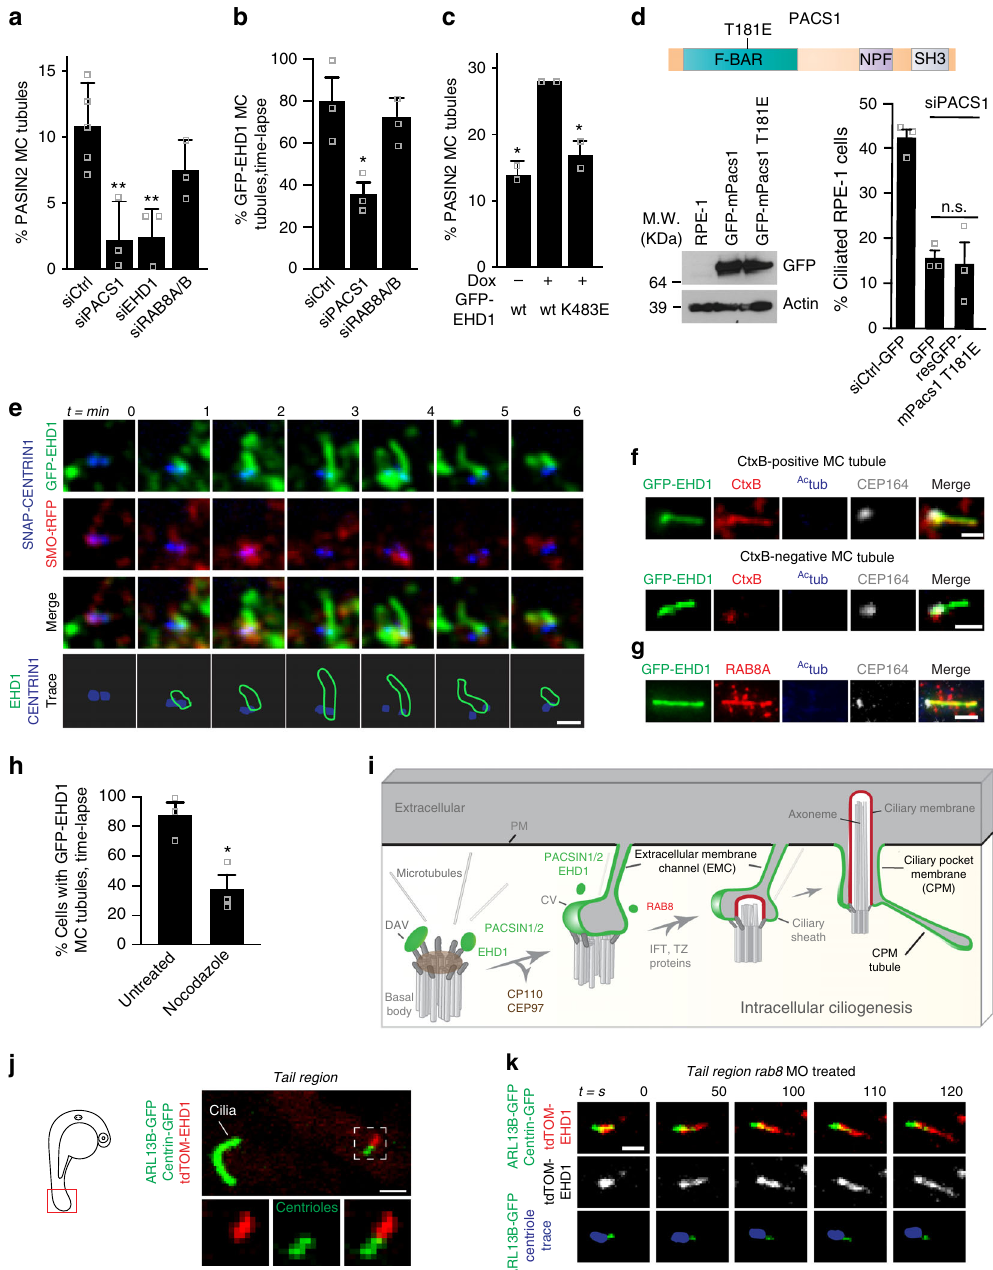
Fig. 8 MC-membrane tubules are PACSIN1-, EHD1- and MT-dependent and form in vivo. a Quanti fi cation of PACSIN2 positive MC-tubules in cells as in Fig. 6c following siRNAs treatments (siCtrl = 258 cells, n = 5; siPACS1 = 168, siEHD1 = 75, siRAB8A/B = 147 cells, n = 3). b Quanti fi cation of GFP-EHD1- positive MC-tubules from triple line treated with siRNAs, starved 3 h and imaged every 2 min for 30 min (siCtrl = 35, siPACS1 = 36, siRAB8A/B = 57 cells, n = 3). c Quanti fi cation of MC-tubules from cell lines starved for 3 h and stained with PACSIN2 and CEP164 antibodies (wt − dox = 262, wt + dox = 142, K483E + dox = 177 cells, n = 2). d Schematic of the T181E tubulation defective mutation in the F-BAR domain of mPacsin1 (top). Immunoblot analysis of cells transfected with wildtype- or T181E-mPacsin1 after 6 h of siRNA treatment (bottom left) and ciliation rescue experiment (bottom right, siCtrl = 108, GFP = 71, rescT181E = 85 cells, n = 3). e Images of the 3 h starved triple line taken every minute. Membrane tubules are outlined in green and centrioles in blue (bottom panel, 15 MC-tubules). Single xy planes were smoothed. f Single plane xy epi fl uorescence images of 3 h starved GFP-EHD1 cells that were CtxB positive (~5% of cells). 53% of GFP-EHD1 MC-tubules contained CtxB (12 MC-tubules). g Images of GFP-EHD1 cells as in f stained with RAB8A, Ac tub, and CEP164 antibodies (10 cells). Scale bars: 1 μ m in ( e - g ). h Quanti fi cation of cells as in b treated with 10 μ M Nocodazole (untreated = 38, Nocodazole = 40 cells, n = 3). i Model for intracellular ciliogenesis. DAV distal appendage vesicle, CV ciliary vesicle, IFT intra fl agellar transport, TZ transition zone, PM plasma membrane. In a – d and h , means ± SEM and two-tailed t -test analyses are indicated in fi gure. * P < 0.05, ** P < 0.001, non signi fi cant (n.s). j Live image of the tail (red box, left schematic) from a 24 hpf embryo showing a tdTom-EHD1 positive MC-tubule (white box, 9 MC- tubules). k Timelapse of MC-tubule formation (centrioles in blue) as in j from embryo injected with rab8 MO (11 MC-tubules). Scale bars: 2 μ m in j and